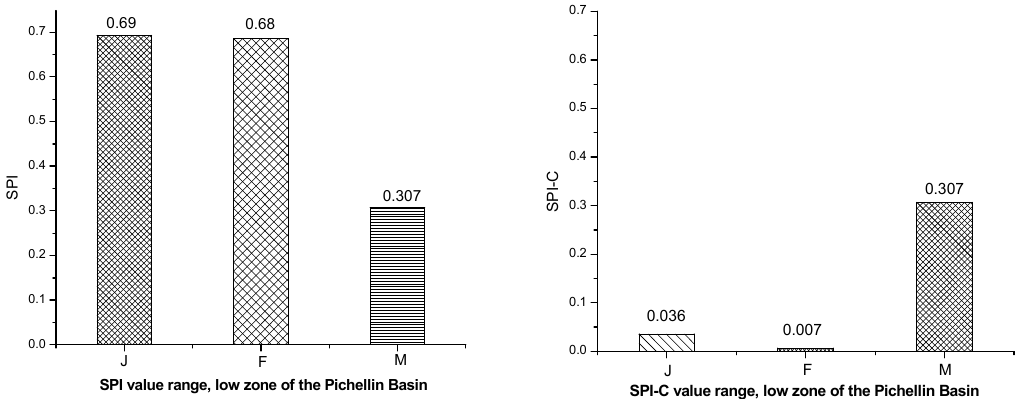
In the middle and high zone, the SPI obtained the same values as the SPI calculated initially. This is because the correction is made for months that exceed the zero precipitation in more than half of the available data. The SPI-C substantially reduced these values of the index, falling in the month of January from Z = 0.693 → Z = 0.036 and in the month of February from Z = 0.686 → Z = 0.007, classified as normal in the classification table of the SPI suggested by [2]. There was a considerable reduction in the SPI-C values, in the months in which zero was presented in more than half of the monthly precipitation data, as can be seen in Figure 17.